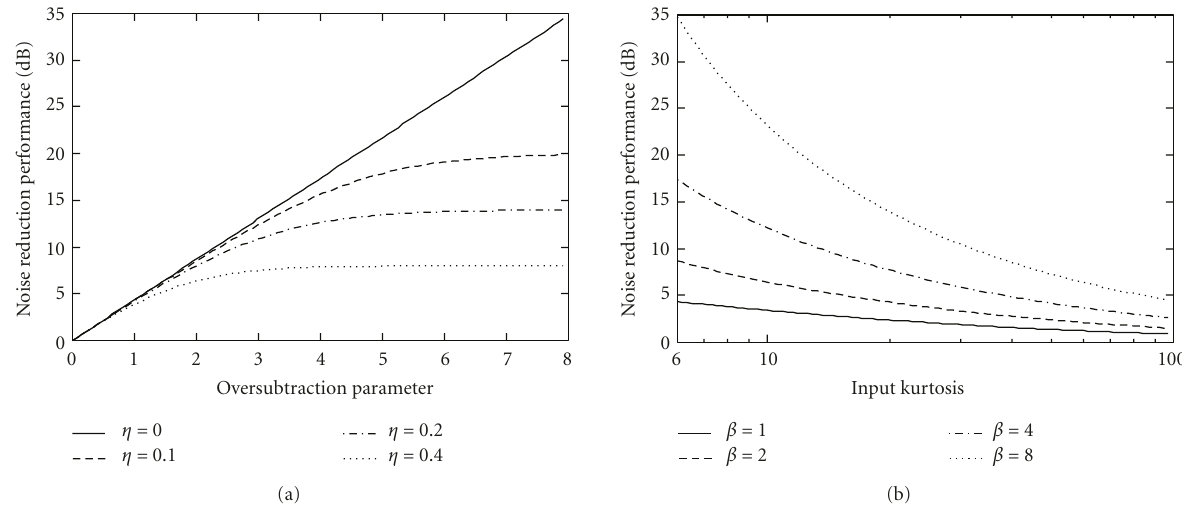
Figure 10: (a) Theoretical noise reduction performance of SS with various oversubtraction parameters β and flooring parameters η . In this figure, kurtosis of input signal is fixed to 6.0. (b) Theoretical noise reduction performance of SS with various values of input kurtosis. In this figure, flooring parameter η is fixed to